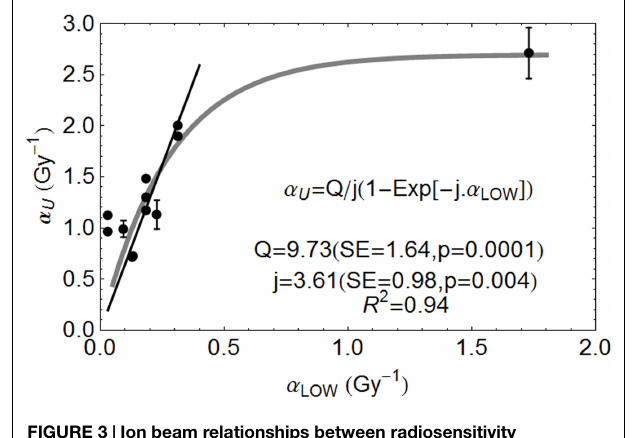
FIGURE 3 | Ion beam relationships between radiosensitivity parameters at low and high LET at the turnover point ( ααα H is here ααα U ) and fitted by the parameters shown, using Mathematica software . Error bars are not available for all data used. Reproduced with permission from Ref. ( 8).